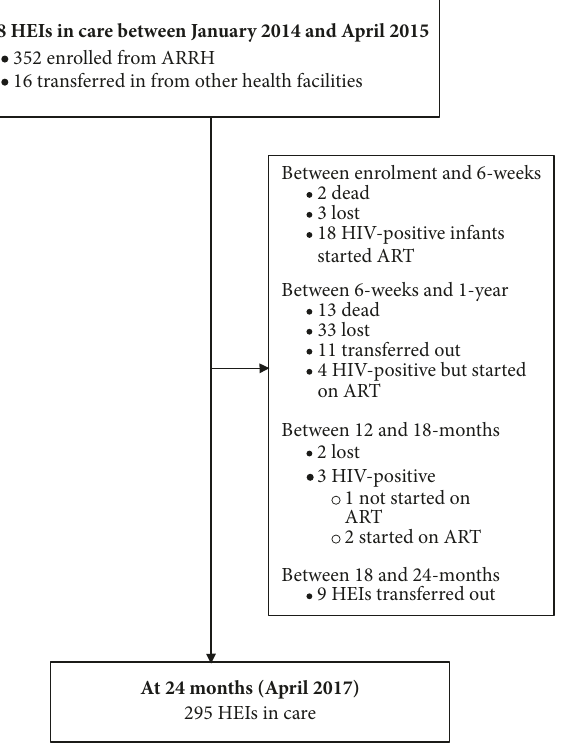
Figure 1: Outcomes of HEIs in 24-month EID continuum of care at ARRH, Northwestern